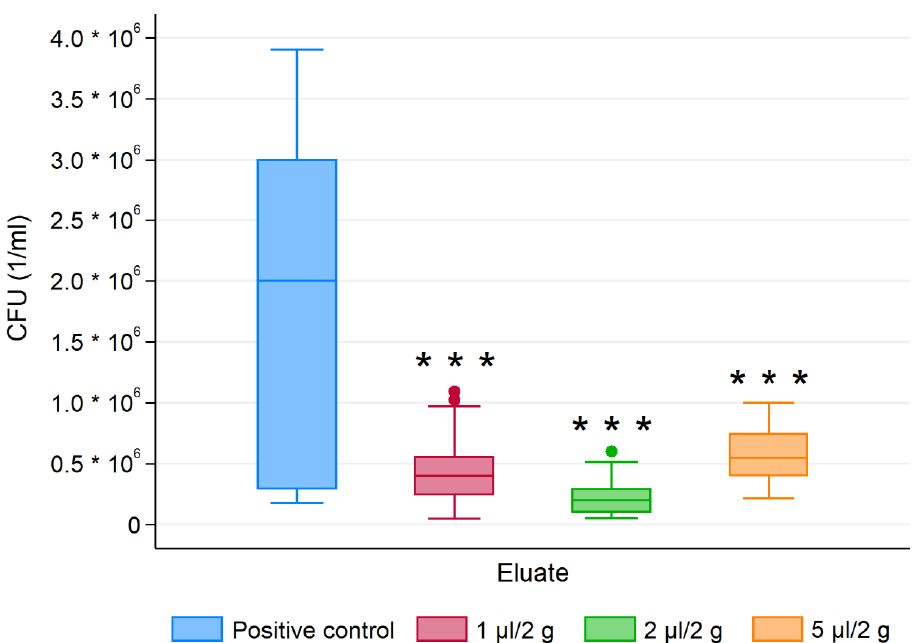
Figure 5. Colony forming units (CFU) of S. mutans for essential oil modified composite resins and the control group. *** p < 0.001 versus control.